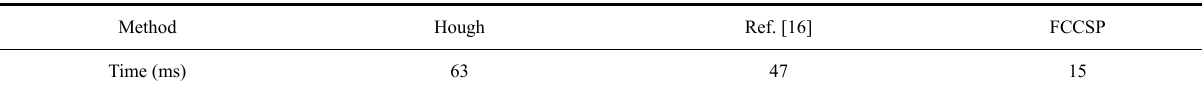
Fig. 9 Different poses of the cooperative target: (a) pose 1, (b) pose 2, (c) pose 3, (d) pose 4, and (e) pose 5. Table 1 Time spent on image center